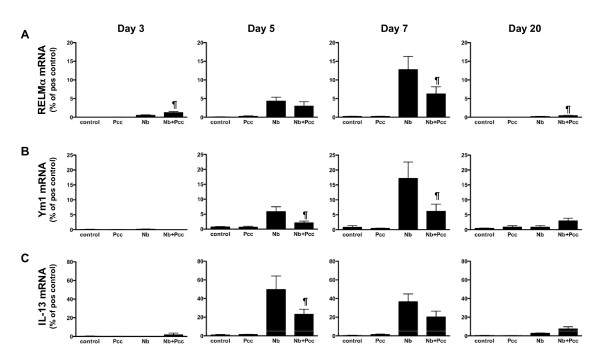
ChaFF and IL-13 mRNA expression in the lungs of Nb, Pcc and co-infected mice. Real-time RT-PCR of mRNA from lung tissue harvested at 3, 5, 7 or 20 days pi showed that the effect of Pcc on Nb-induced expression of RELMα (A) and Ym1 (B) changed over time. RELMα was transiently elevated in co-infected (Nb+Pcc) compared to Nb mice at 3 days pi (P = 0.0257), but expression of mRNA for RELMα (A), and Ym1 (B) was then found to be significantly lower in the lungs of Nb+Pcc mice than in Nb mice by 7 days pi (RELMα, P = 0.0113; Ym1, P = 0.005). IL-13 mRNA expression (C) largely mirrored this pattern, as it was significantly reduced in Nb+Pcc mice compared to Nb mice at 5 days pi (P = 0.0169). At 20 days pi, however, RELMα (A) was again significantly elevated in Nb+Pcc relative to Nb mice. (P = 0.01) Data are expressed as percentage of positive control samples (for RELMα and Ym1, peritoneal macrophages of a mouse implanted with Brugia malayi adult parasites for 3 weeks [72]; for IL-13, spleen of an MHV-68 infected IFNγR-KO mouse [63]). Bars indicate mean ± SEM of 2 combined independent experiments, each with 4-9 mice per group per timepoint. The symbol ¶ indicates significance of the difference between co-infected and Nb mice (P values included above and in Results text).